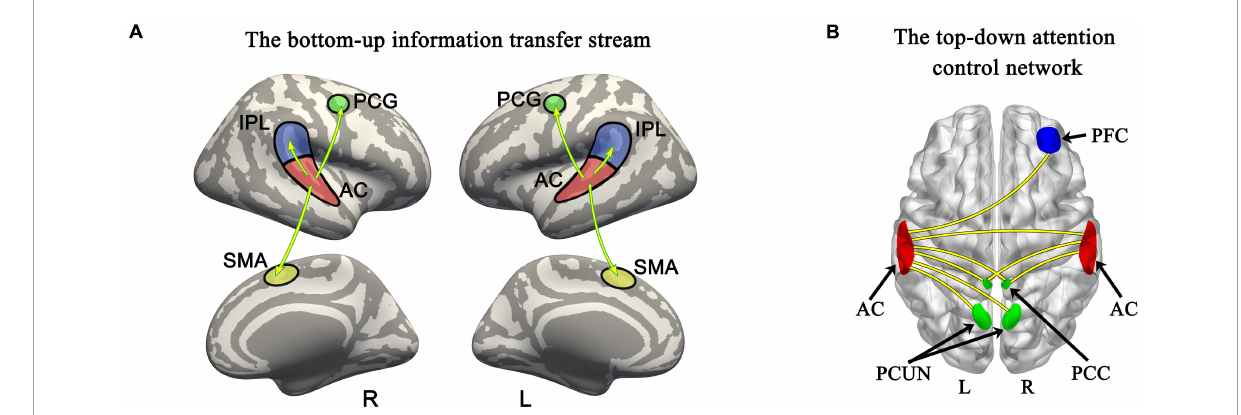
FIGURE5 Bottom-up information transfer process and top-down attention control network during tonal working memory. (A) The information transfer process during tonal working memory. (B) The attention control network during tonal working memory. PCG, precentral gyrus; AC, auditory cortex; IPL, inferior parietal lobule; SMA, supplementary motor area; PFC, prefrontal cortex; PCC, posterior cingulate cortex; PCUN,